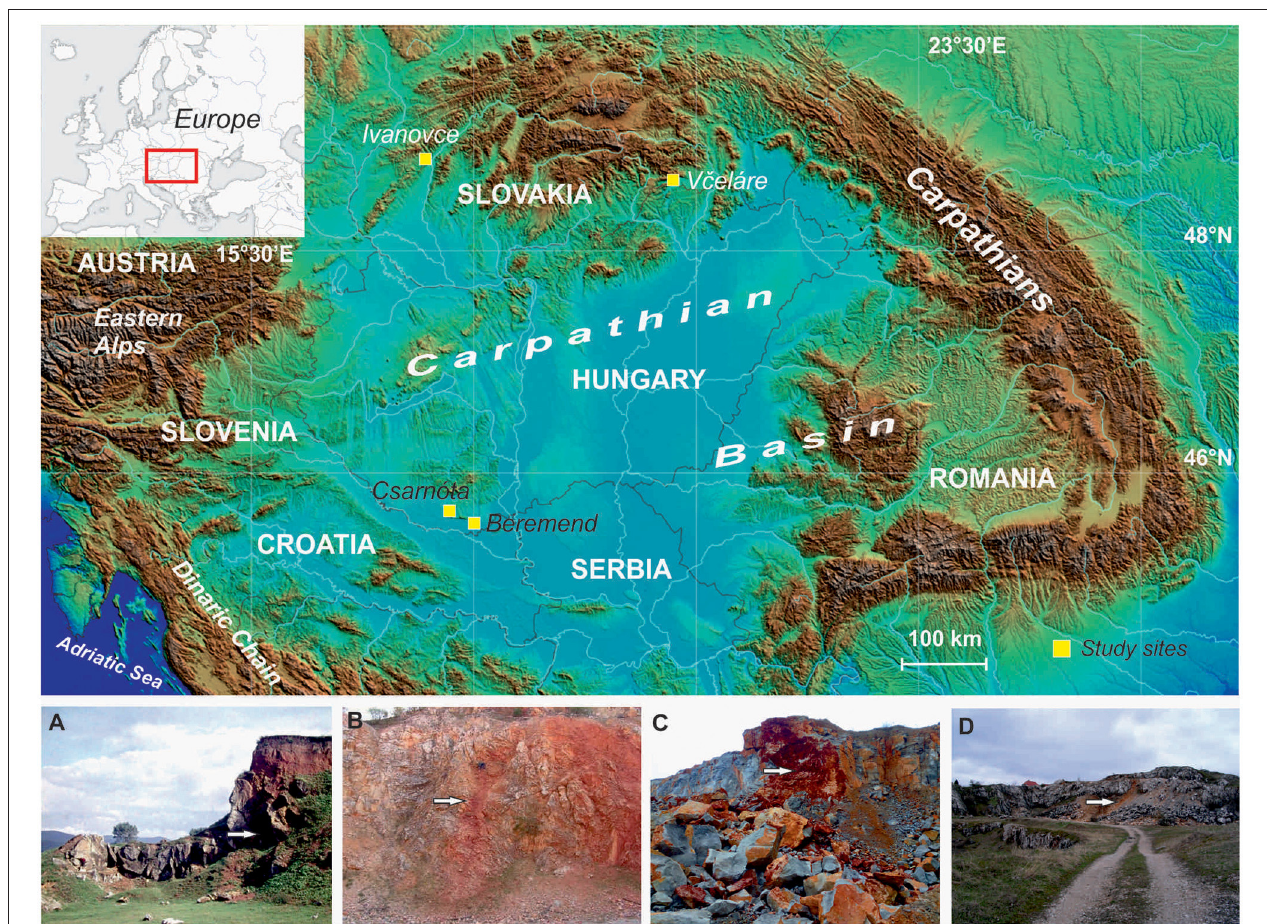
FIGURE 1 | Map of the study area in the Carpathian Basin. Study sites are: (A) Ivanovce; (B) V ˇ celáre; (C) Beremend; (D) Csarnóta. The white arrows show the sampling points (Original map: DEM map of the Pannonian Basin, © Dept. of Geophysics, Eötvös